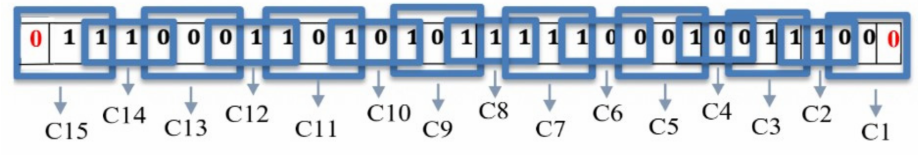
Figure 3. How the multiplier’s (MR) bits will be